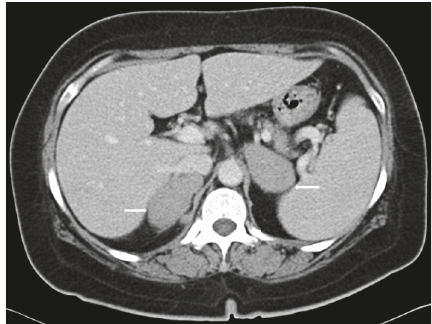
Figure 1: At the time of diagnosis. Imaging studies of patient, CT thorax, and abdomen, and pelvis show bilateral adrenal masses which are homogenous measuring 3.7 × 5.4 × 6.3 cm on the left (78.3 average HU), while the right adrenal gland measures 5.5 × 2.7 × 5.9 cm (72.7 average HU).